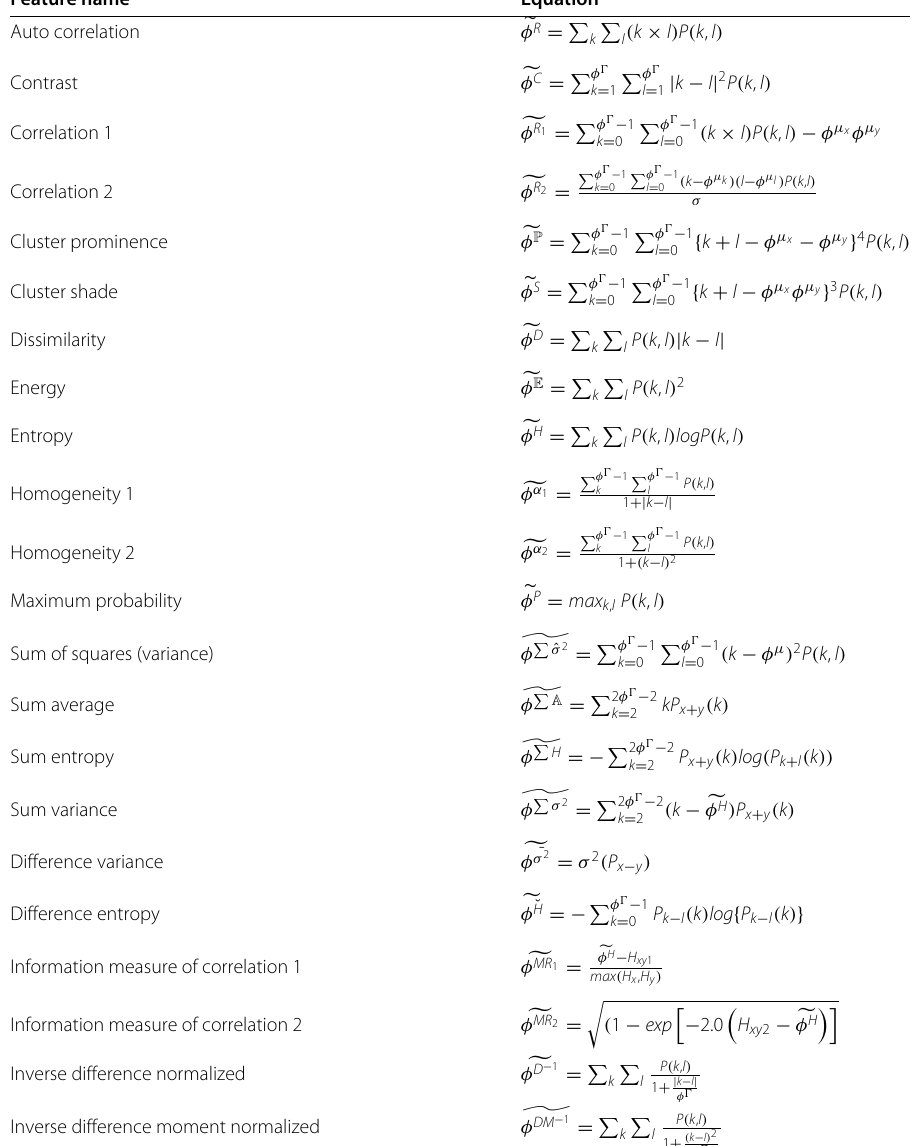
Table 3 Extraction of twenty-two GLCM